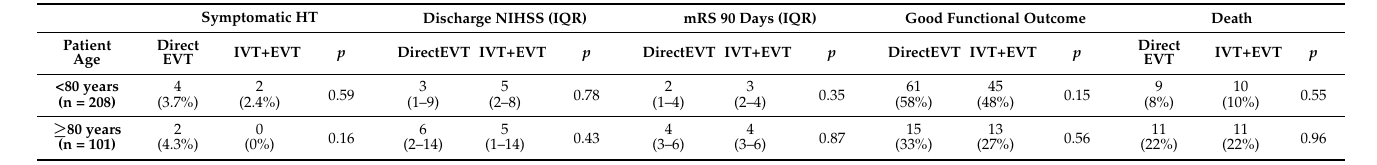
Table 3. Comparison of outcomes in patients aged <80 years and ≥ 80 years, in the direct EVT and IVT+EVT